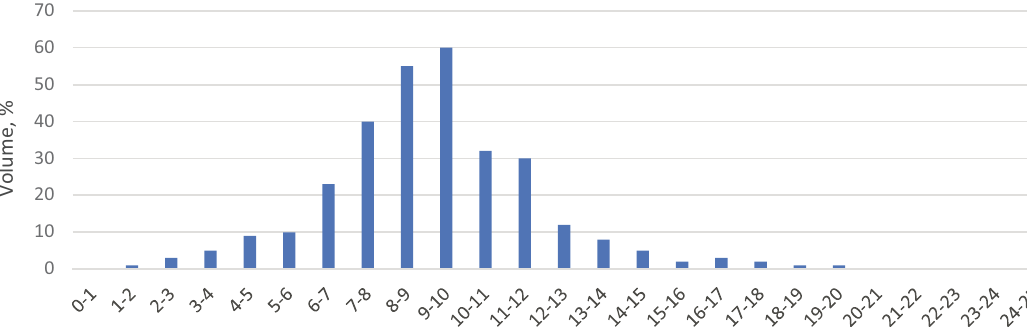
Figure 7: Distribution of particle size in the microcapsules PLA/CA +